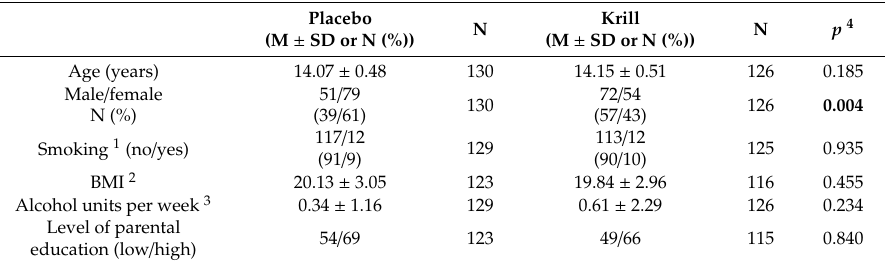
Table 1. Participant characteristics at